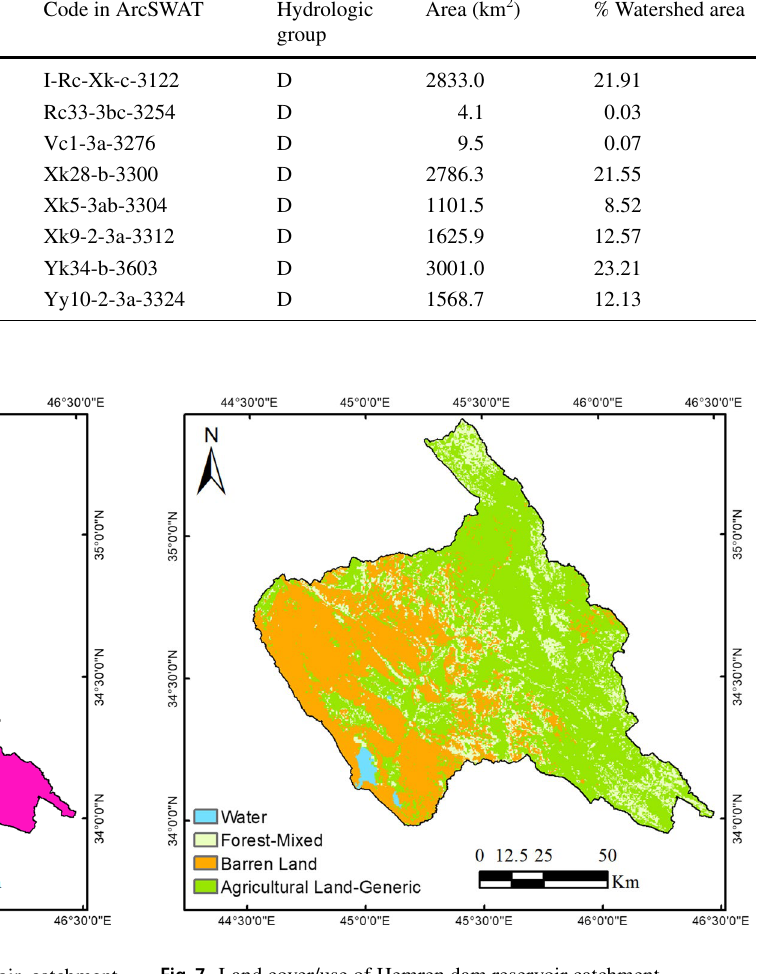
Fig. 6 Land cover/use change in Hemren dam reservoir catchment during 1992–2008